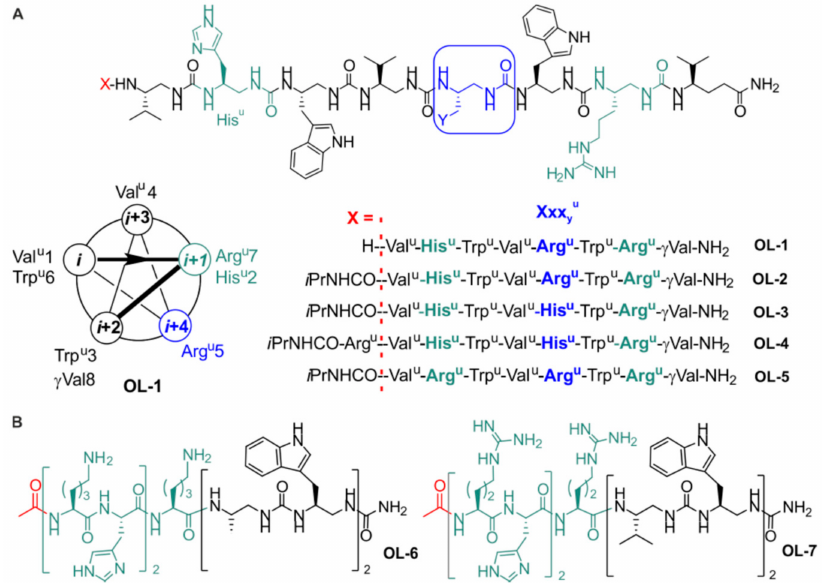
Figure 1. Sequences of the antimicrobial urea-based foldamer candidates. ( A ) Amphiphilic 2.5-helical pure oligoureas evaluated for their antimicrobial activity. A helical wheel representation of oligourea OL-1 is also shown; i Pr stands for isopropyl, superscript “U” indicates urea linkage, and γ is for γ -amino acid. ( B ) Chemical structure of amphiphilic α -peptide–oligourea block cofoldamers OL-6 and OL-7